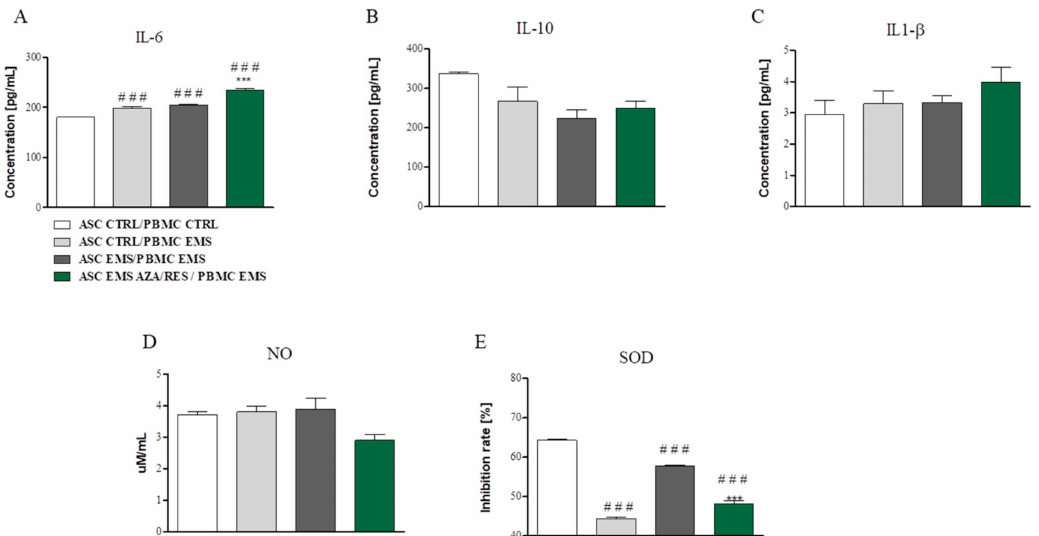
Figure 4. Cytokines, nitric oxide (NO), and superoxide dismutase SOD amounts evaluated after co-culture of ASCs with PBMCs. Culture media after co-culture was collected and subjected for analysis. Using ELISA ( A ) amount of IL-6 ( A ), IL-10 ( B ) and IL-1 β ( C ) was evaluated. Using spectrophotometric assays NO ( D ) and SOD ( E ) levels were investigated. Statistical significance was labelled with hash (#) when comparing to control group (ASC CTRL /PMBM CTRL ) and asterisk (*) when comparing to the EMS group (ASC EMS /PBMC EMS ). Results expressed as mean ± S.D. ###, *** p <